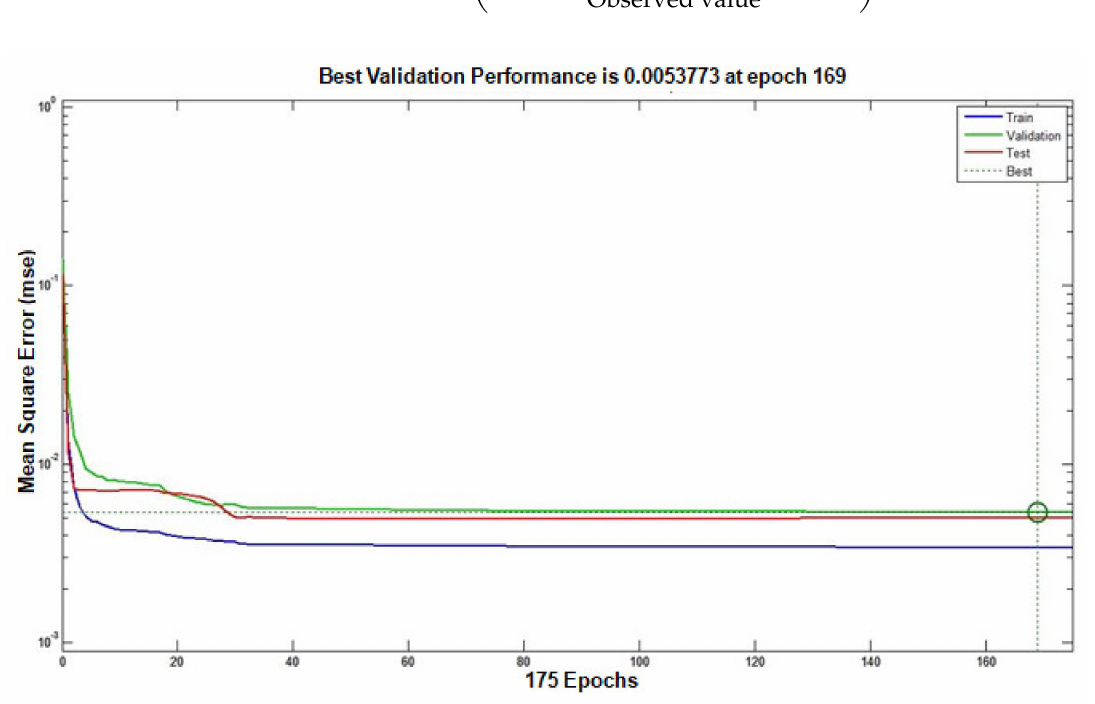
Figure 7. Network 4-2-3 performance graph for angular distortion showing time gap between two, three and four passes.